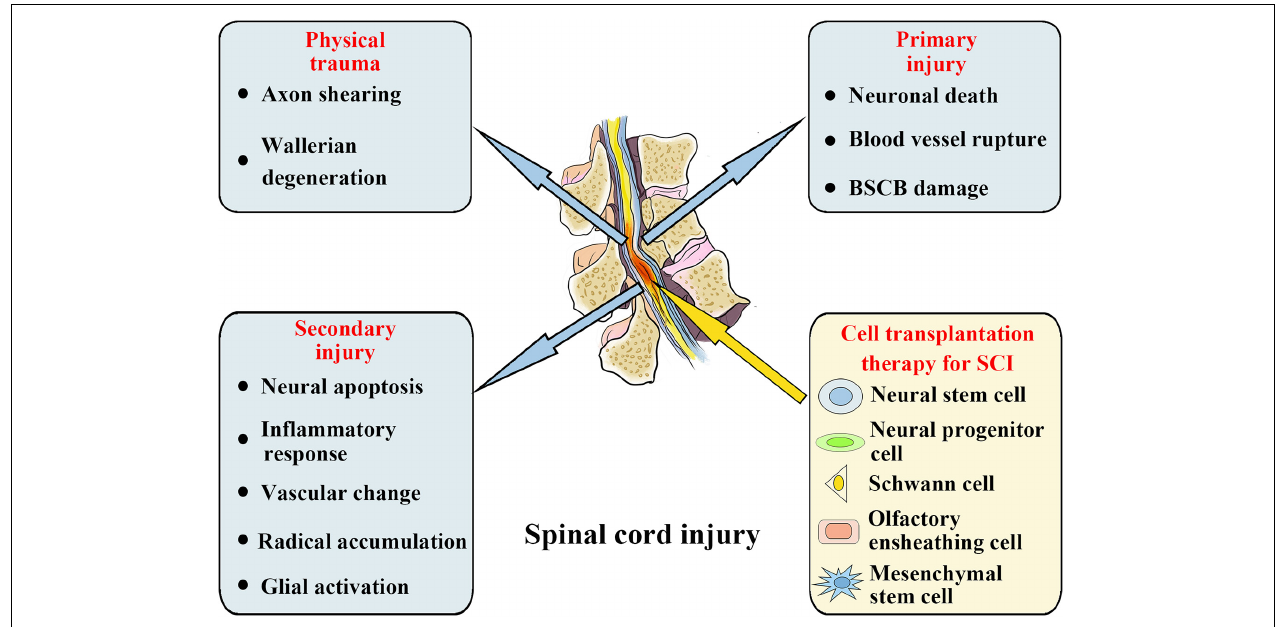
FIGURE 1 | Spinal cord injury: Pathophysiological events and potential stem cell